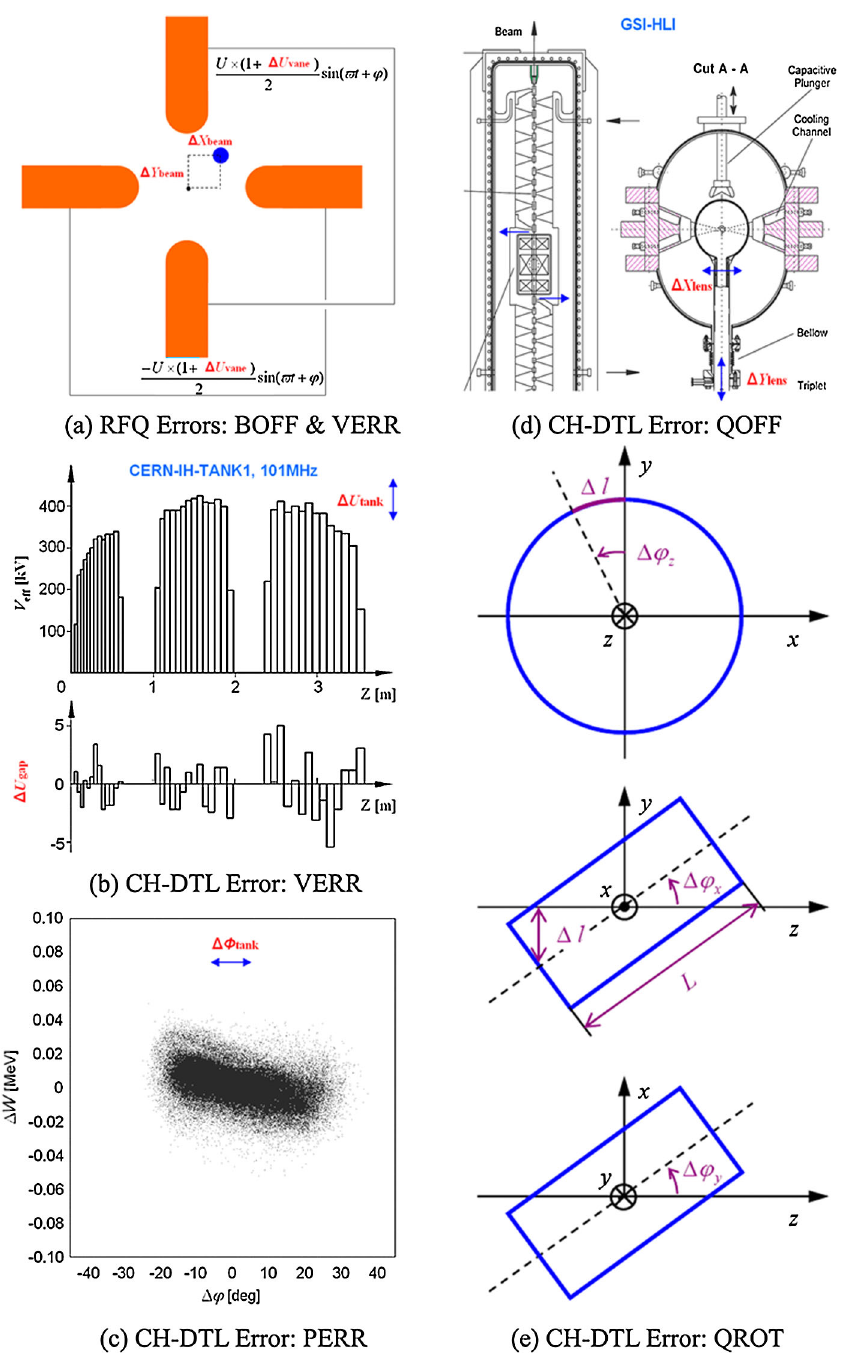
FIG. 14. (Color) Illustration of the RFQ and CH-DTL errors applied to the injector by examples (see Table III for descriptions of the